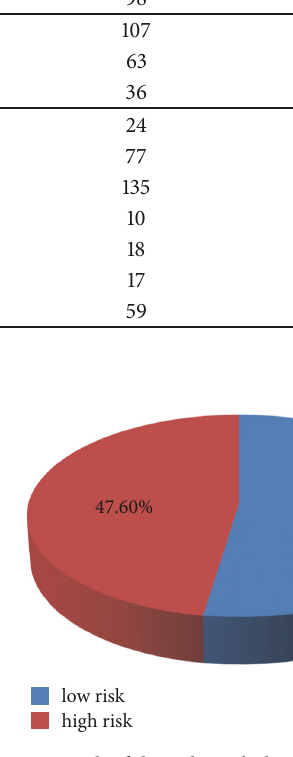
Figure 1: Risk of thromboembolism among study subjects.